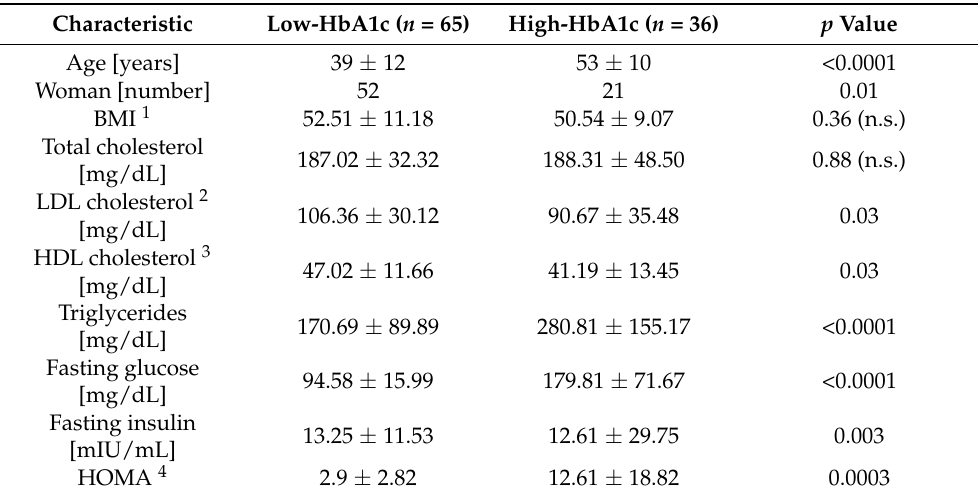
Table 3. Metabolic parameters of the human cohort used for pyrosequencing and qPCR.